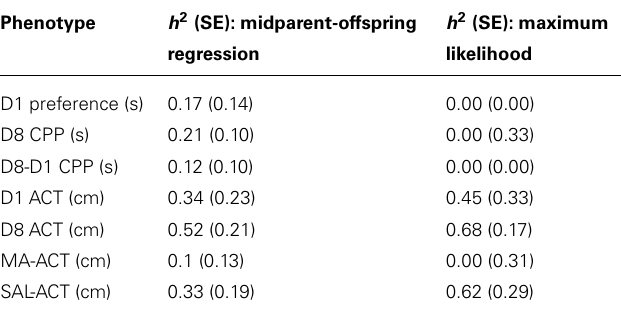
Table 2 | Heritability estimates of preference and locomotor phenotypes inAIL